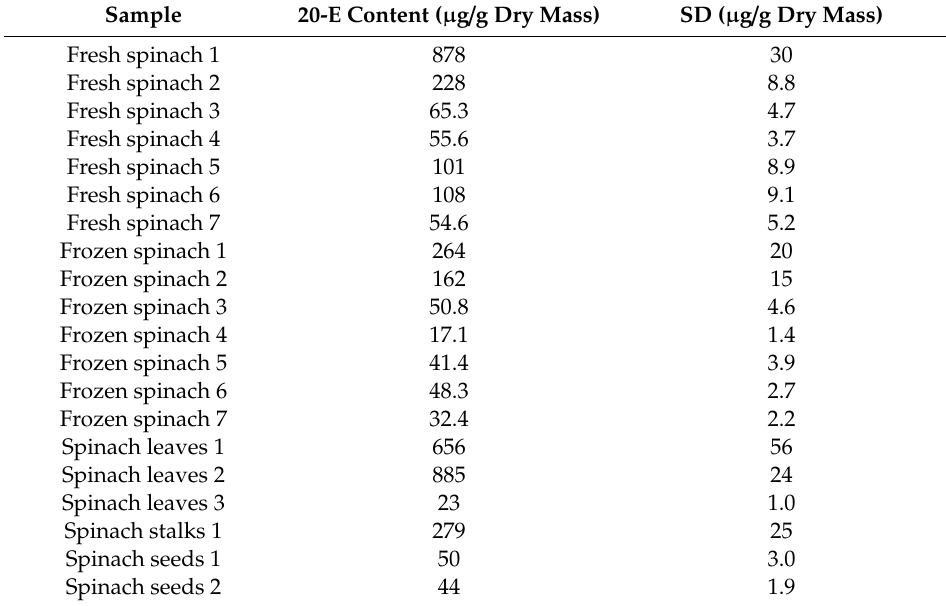
Determination of 20-E in spinach samples using NADES-SLE-UHPLC-UV and IL-SLE-UHPLC-UV